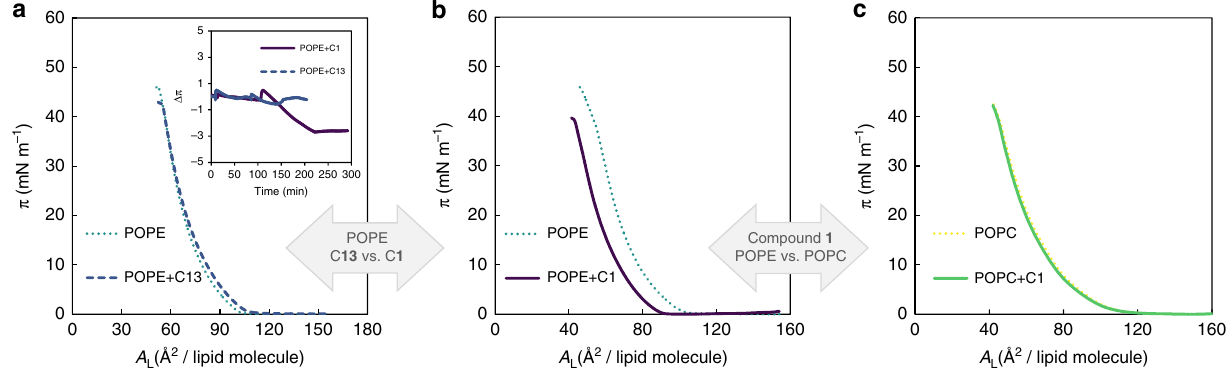
Fig. 8 Effect of 1 and 13 on the compression isotherm of POPE or POPC. a Compression isotherms of a POPE monolayer before (light blue line) and after (dark blue line) incubation with compound 13 (0.2 µ M). b Compression isotherms of a POPE monolayer before (light blue line) and after (purple line) incubation with compound 1 (0.2 µ M). c Compression isotherms of a POPC monolayer before (yellow line) and after (green line) incubation with compound 1 (0.2 µ M). Changes in surface pressure ( Δ π ) of preformed POPE monolayers at π ~ 25 mN m − 1 induced by compound 1 (purple line) or 13 (dark blue) are also shown (inset in a ). The compounds were present at the concentration 0.1 µ M after the fi rst addition (5 min) and at concentration 0.2 µ M after the second addition (90 min). The maximum values of Δ π are 2.61 ± 0.25 mN m − 1 for compound 1 and 0.15 ± 0.06 mN m − 1 for compound 13 ( n =